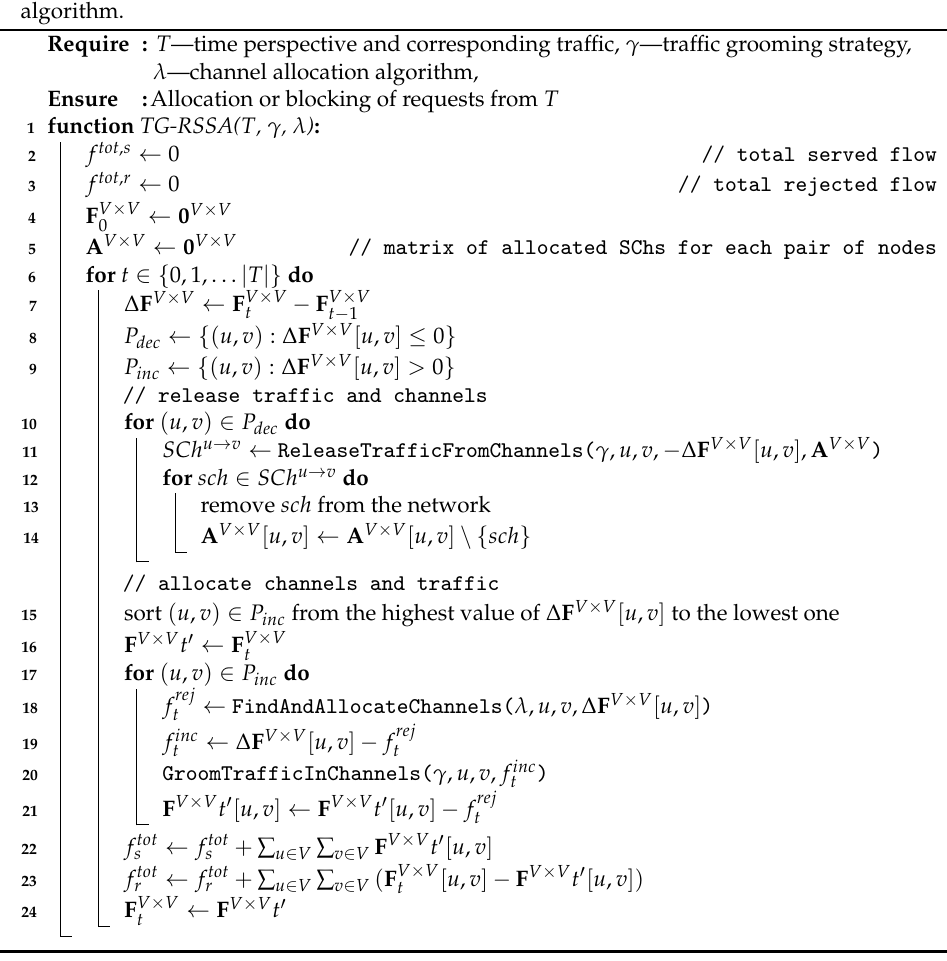
Algorithm 1: Traffic grooming, routing, space, and spectrum assignment (TG-RSSA)